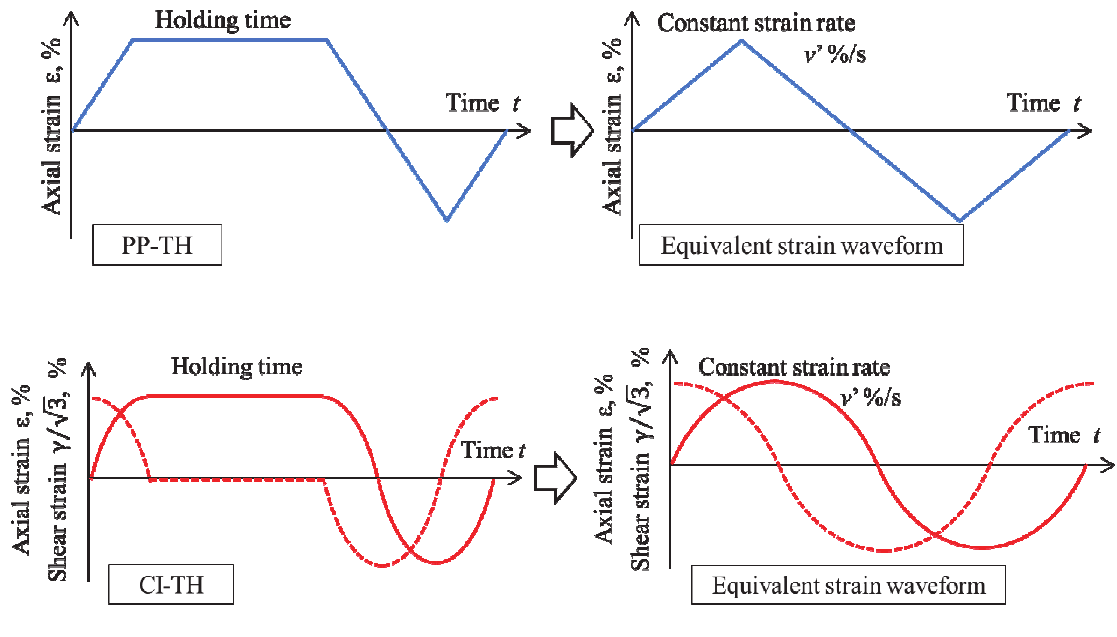
Figure 6: Assuming waveform of hold loading equivalent to triangular